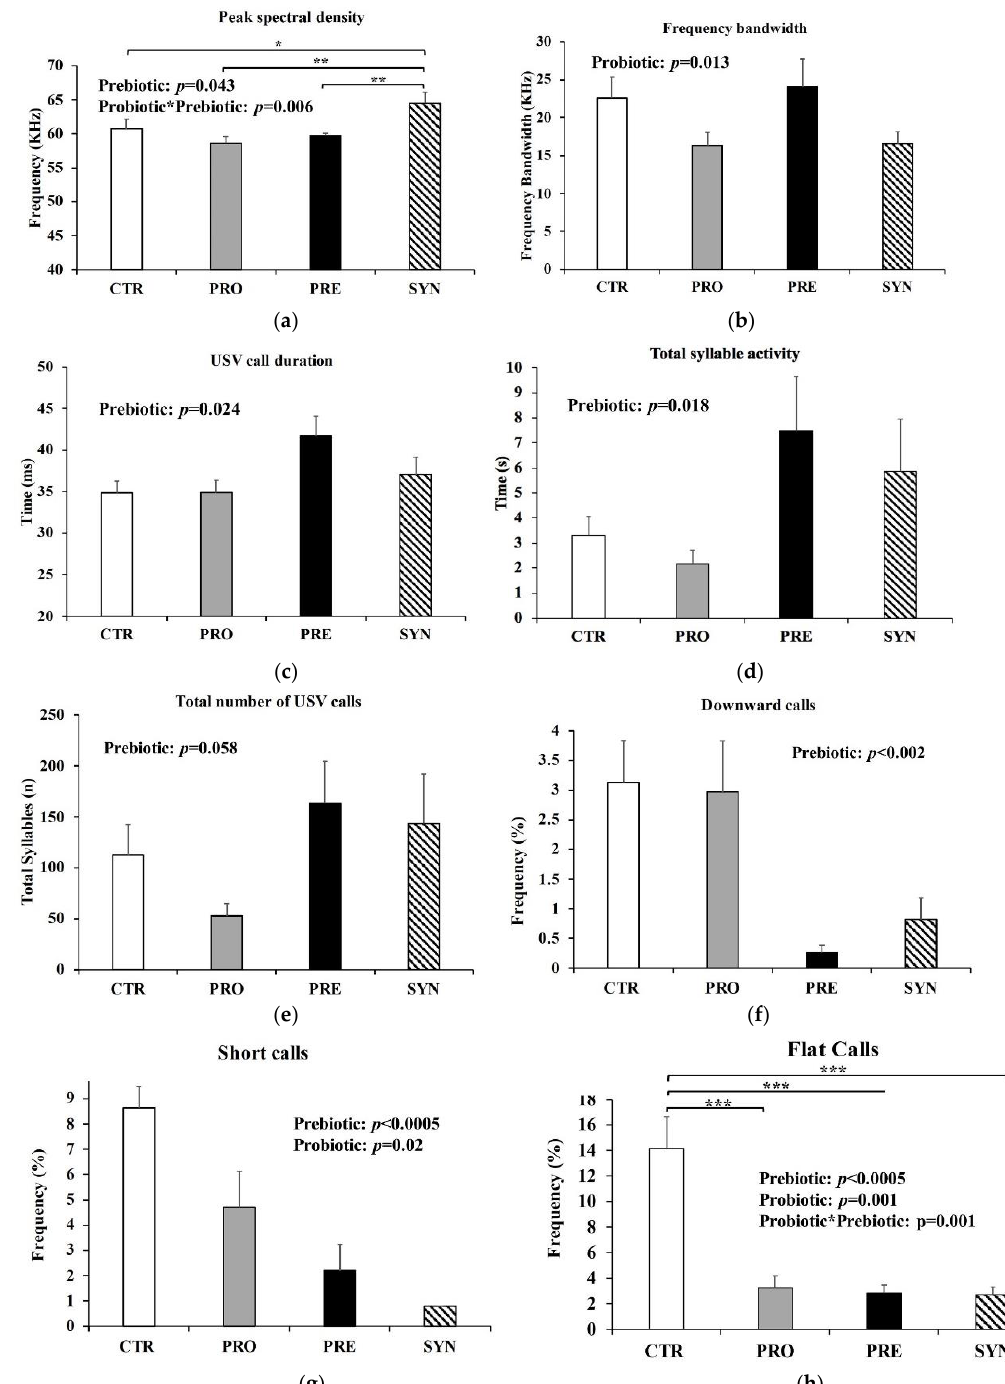
Figure 3. USV calling behavior of BTBR mice during a five-minute testing period at postnatal day 43 after consuming a control, probiotic, prebiotic, or synbiotic diet for three weeks. ( a ) Peak spectral density; ( b ) frequency bandwidth; ( c ) total USV call duration; ( d ) total syllable activity; ( e ) total number of USV calls; ( f ) frequency of downward-style calls; ( g ) frequency of short-style calls; ( h ) frequency of flat-style calls. Values or mean ± SEM, n = 7–8/group. P-values presented in the figure represent the main effects and interaction effects from the two-way ANOVA. * p ≤ 0.05; ** p < 0.025; *** p < 0.0005. CTR, control; PRO, probiotic; PRE, prebiotic, SYN,